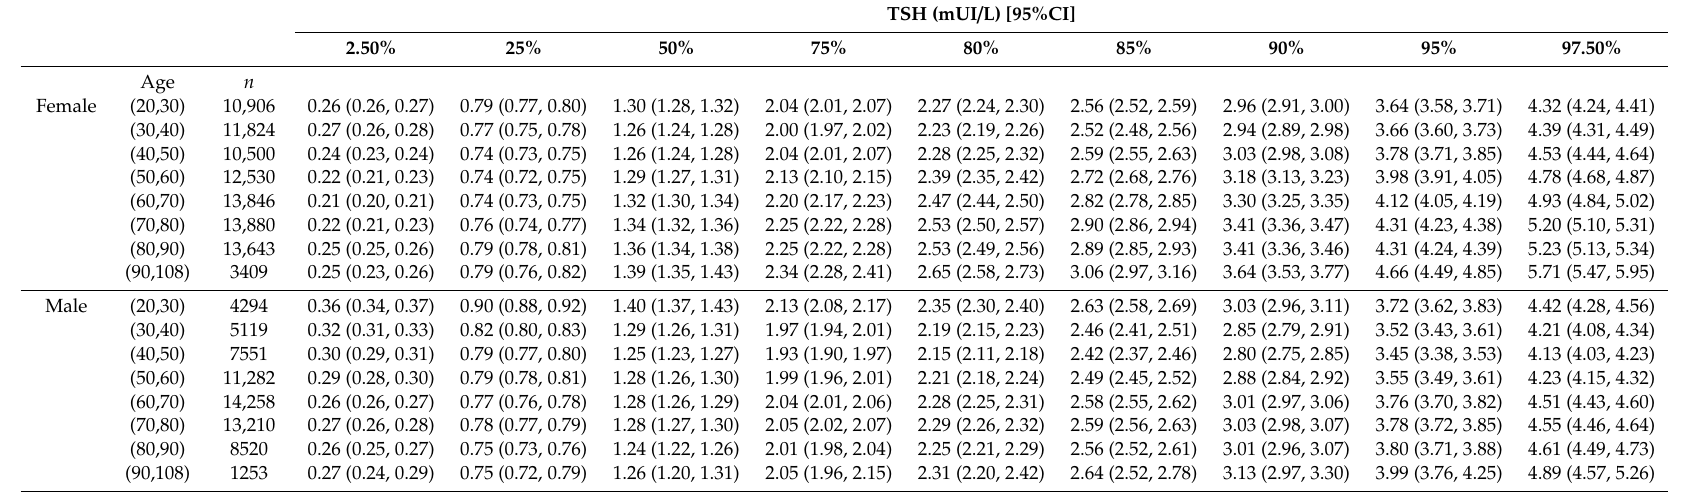
Table 1. Modeled serum thyrotropin (TSH) according to quantile, sex and age group (reference values are given by 2.5th and 97.5th